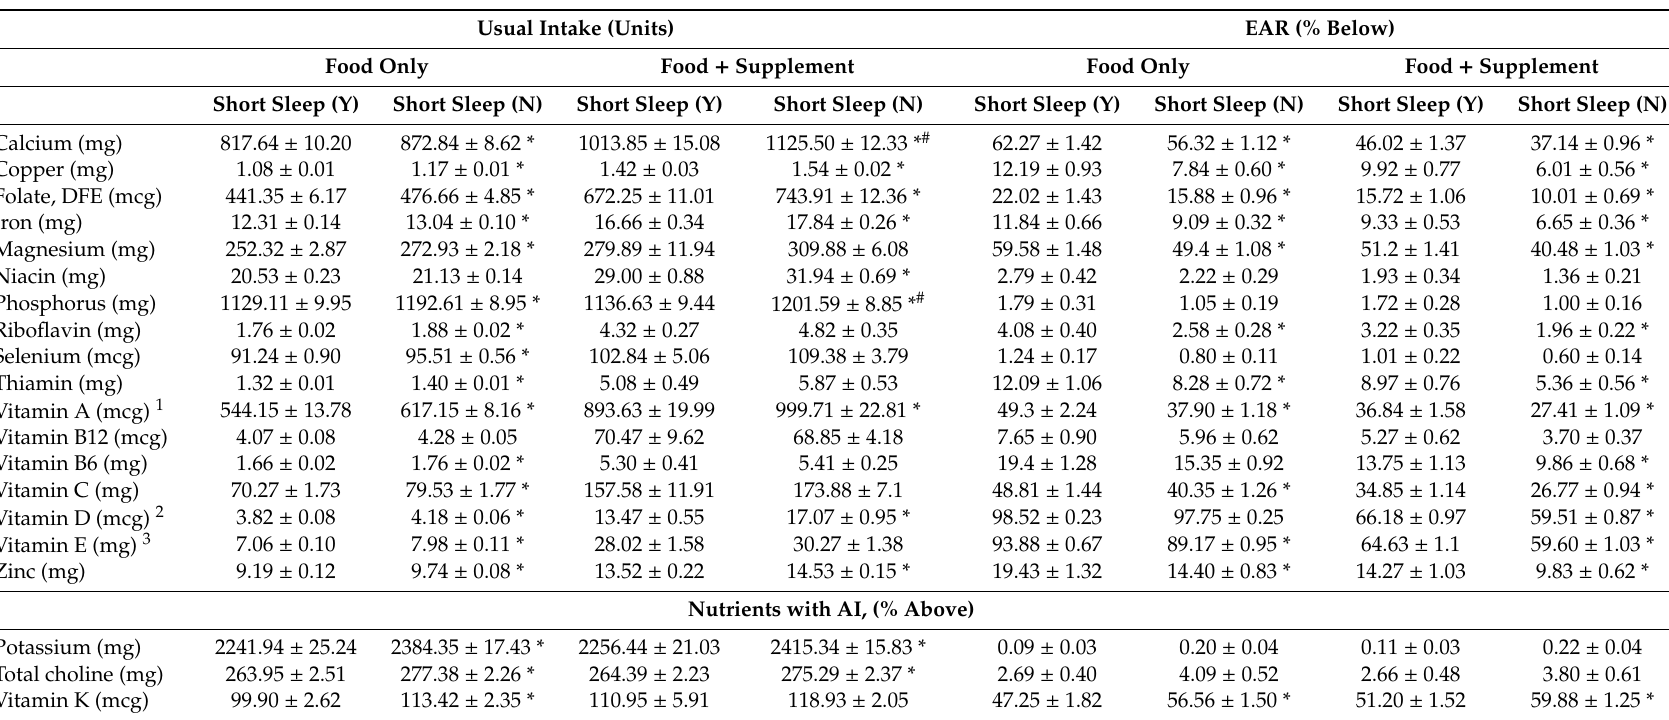
Table 3. Micronutrient usual intake (UI) (Food Only and Food + Spp) and inadequacy (% below estimated average requirement (EAR)) with and without short sleep duration in females aged 19 +